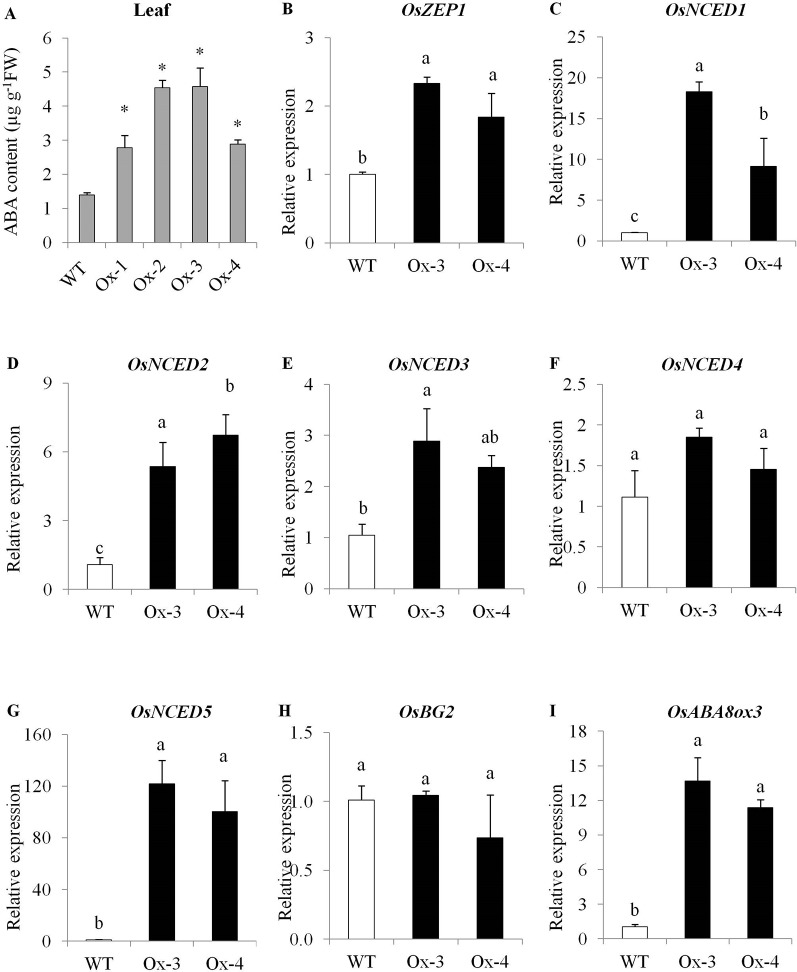
PYL10 regulates ABA content and genes for ABA metabolism. (A) PYL10 overexpression enhances ABA content in transgenic rice. (B–I) qRT-PCR gene expression of genes for ABA biosynthesis viz., OsZEP1, OsNCED1, OsNCED2, OsNCED3 and OsNCED5, ABA catabolism (OsABA8ox3) and ABA conjugation (OsBG2). Flag leaf sample from about 15 independent plants (biological samples) for each transgenic event were collected at flowering stage under control conditions. The leaves were cut in to small pieces and three replicates of about 1g each was sampled for three replicates for each transgenic event, and ABA was quantified by HPLC method. Part of the same flag leaf sample was used for gene expression analysis. The experiments were performed with three biological replicates. Values are mean (n = 3). Error bar indicates ±SE. Statistical differences are shown on the bars by labelling significantly different groups with different letters. *means P < 0.05.